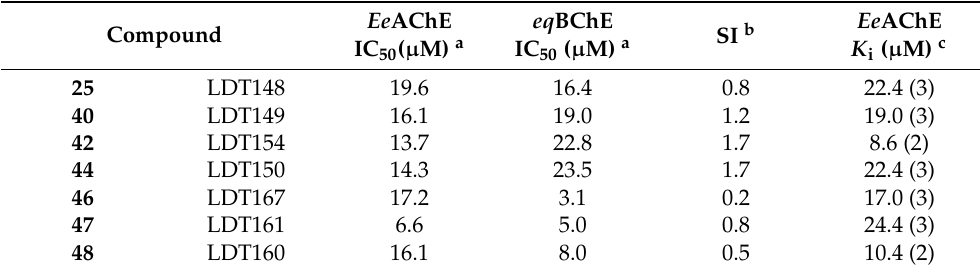
Table 3. Selectivity and cholinesterase inhibition of selected cardanol-derived